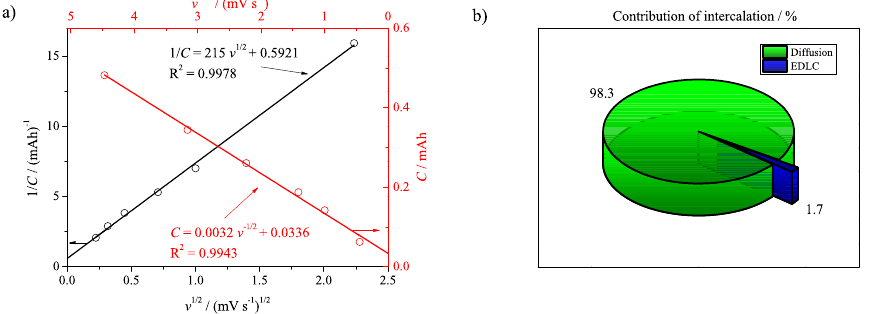
Figure 6. Plots of ( a ) ( ) reciprocal specific capacitance versus square root of a sweep rate, ( ) specific capacitance versus sweep rate, and ( b ) percentage of the intercalation process